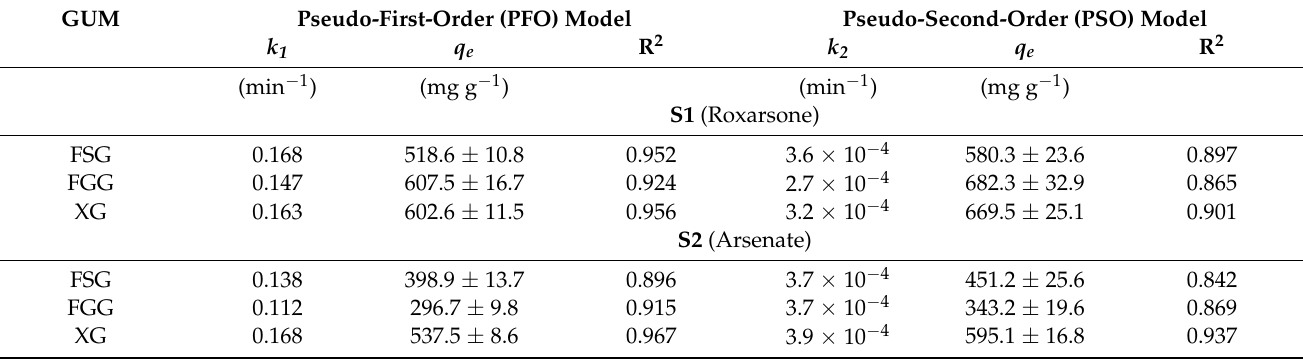
Table 5. Adsorption kinetics parameters for S1 and S2 adsorption over FSG, FGG and XG at 295 K.